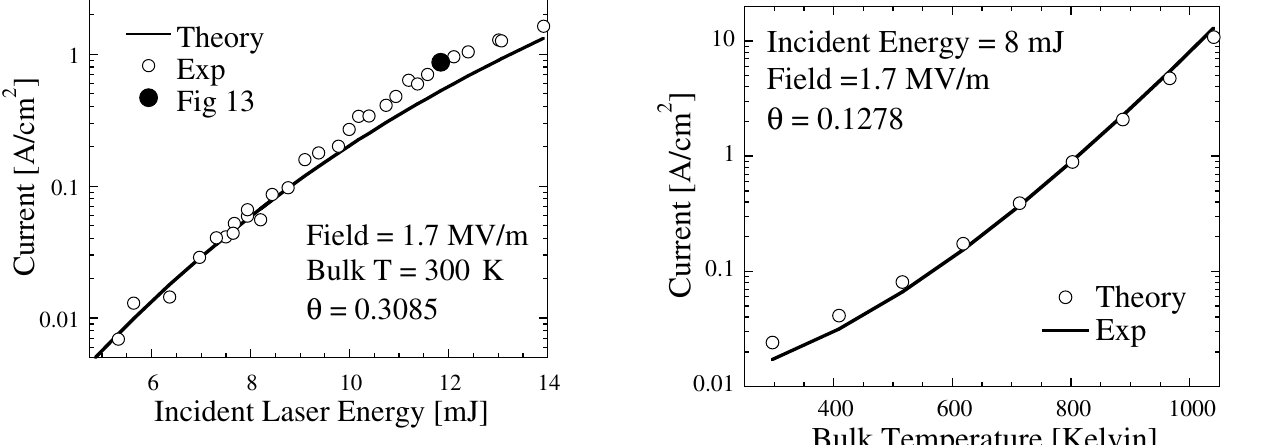
FIG. 10. Same as Fig. 8, but as a function of bulk temperature for a fixed laser intensity and applied field. The same coverage factor as in the 12 mJ case of Fig. 9 was used.